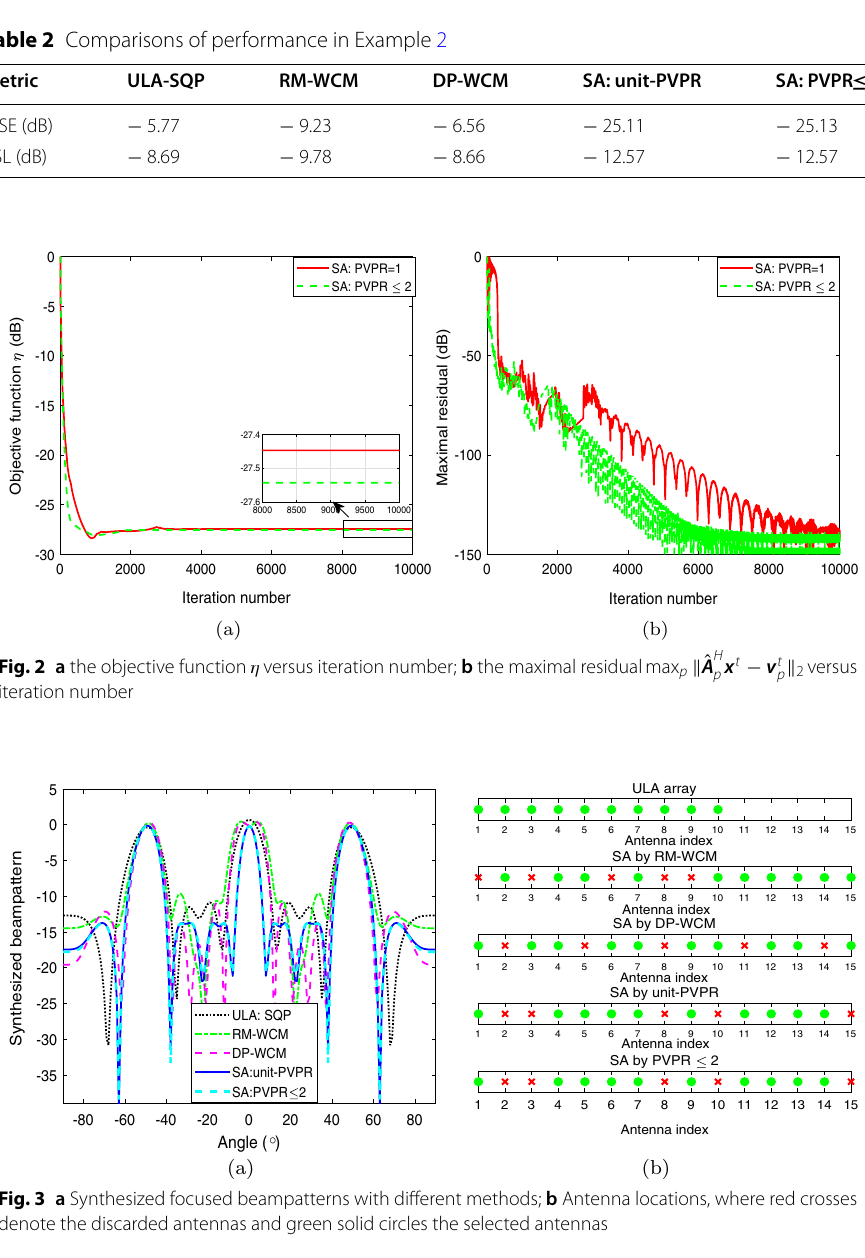
and − 27.44 dB. Clearly, our SIAPC achieves the best beampattern matching design, i.e., 27.44 dB. MSE = −